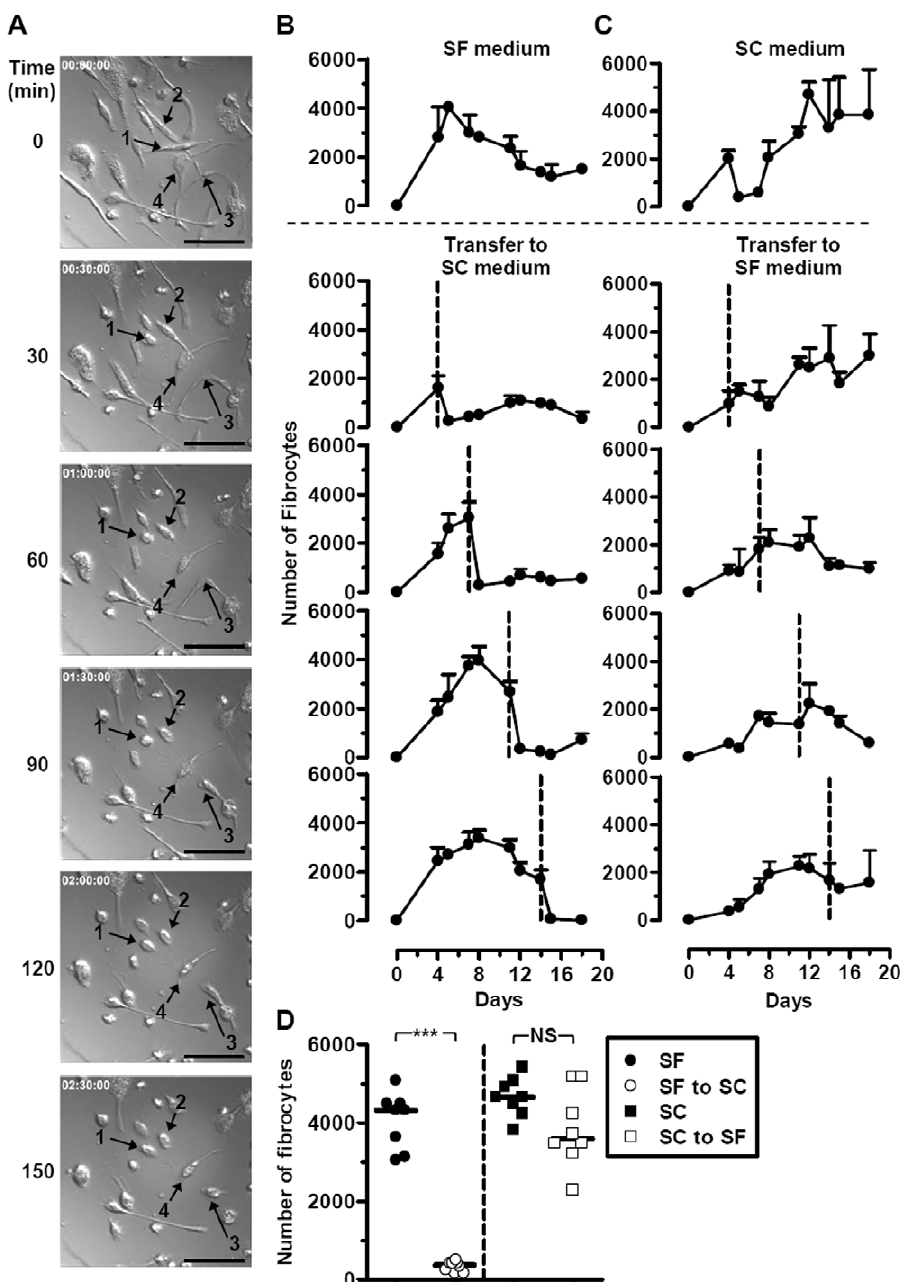
Figure 3. Addition of serum to serum-free generated fibrocytes results in a loss of fibrocyte morphology. Fibrocytes generated from PBMC under serum-free (SF) culture conditions were cultured in the presence of serum-containing (SC) culture medium, and video recordings taken for a period of 150 min. Still photographs are shown after each 30 min period (A), with arrows indicating individual cells that have lost the typical elongated fibrocyte morphology, taking on a more rounded appearance. Bar represents 50 m m. The serum-free culture conditions were changed to serum-containing conditions after 4, 8, 11 and 14 days as indicated by the dotted line (B), with a reciprocal experiment where serum-containing medium was changed to serum-free culture conditions (C). Data are the mean 6 sd of triplicate culture wells and are representative of three separate experiments. The median number of cells with fibrocyte morphology at 24 h after the change of culture conditions from multiple experiments is shown (D). ***=p , 0.001; NS=not significant, p . 0.05; Mann-Whitney test. Error bars are only shown in one direction for